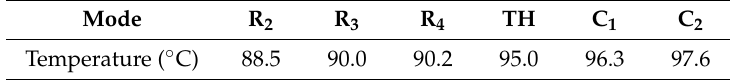
Table 1. Temperature of the minimum in the evolution of the resonance frequency.